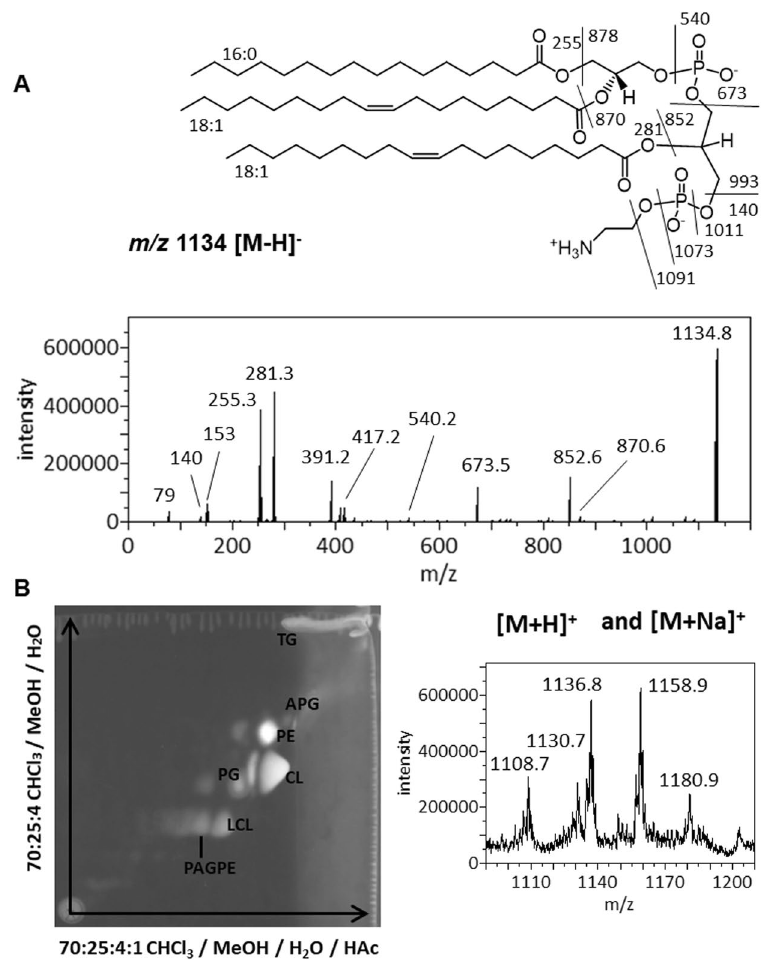
Figure 5. MS/MS spectrum of the m/z 1134 PAGPE anion and 2D-TLC chromatogram. ( A ) Dissociation and MS/MS spectrum of the m/z 1134 deprotonated anion. ( B ) The 2-D-TLC sheet was stained with 0.02% primuline. Representative fluorescent spots were analyzed by MS. The types of lipids recovered from silica gels are marked on the chromatogram. Positive MS spectrum of lipids recovered at the PAGPE spot is